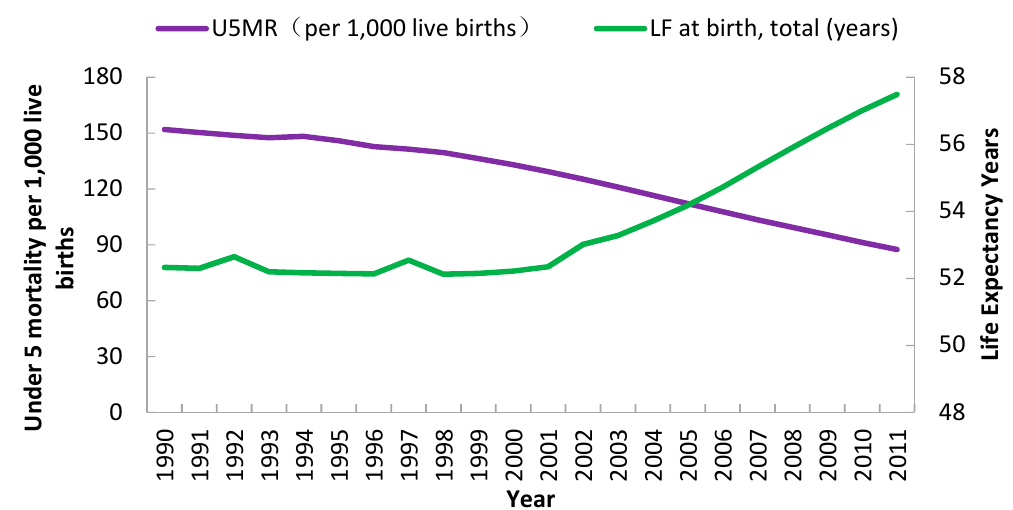
Figure 2. Analysis of trends for U5MR and LE in Sub-Saharan Africa, 1990 to 2011. U5MR relates to purple graphing line and corresponds to the left-hand Y-axis, while LE relates to green graphing line and corresponds to the right-hand Y-axis.